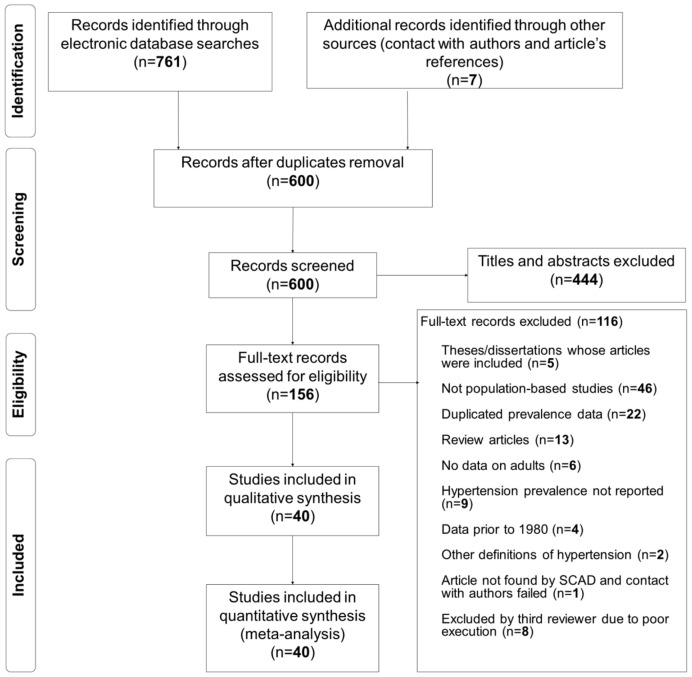
Flowchart of records retrieved, screened and included in the systematic review.